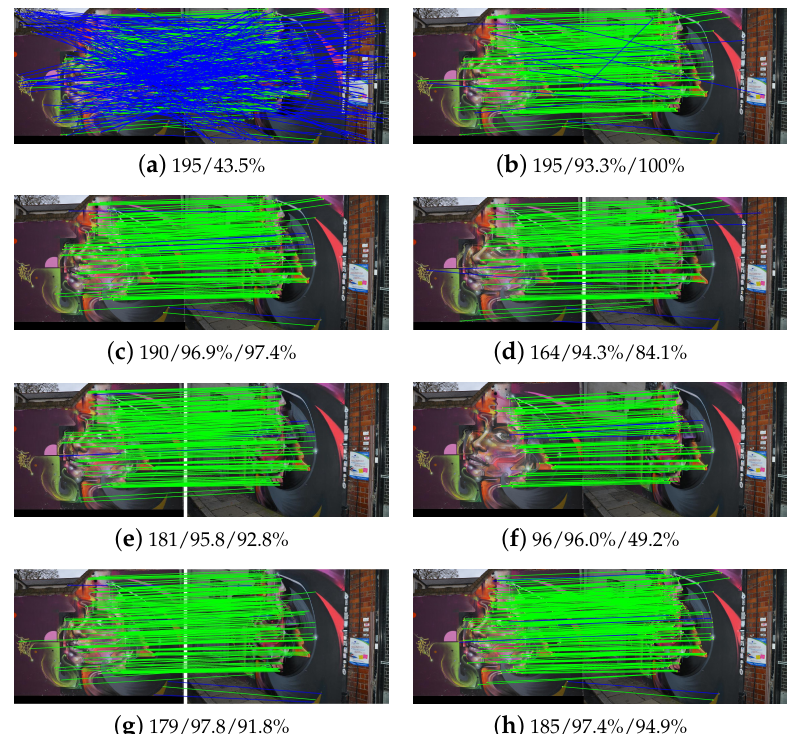
Figure 15. Matching results of image pair 7 in the rigid dataset: ( a ) initial matches; ( b ) RANSAC;